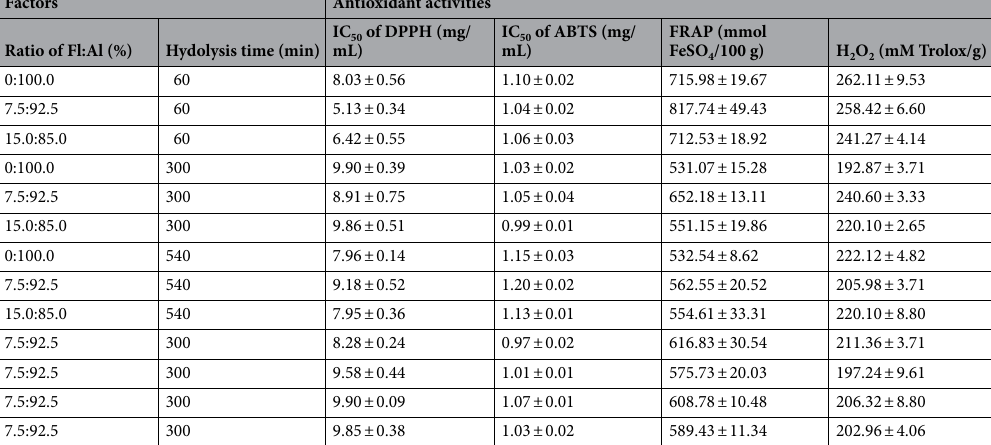
Table 2. Antioxidant activity of rice bran protein hydrolysates with various independent factors. Note: All values are Mean ± SD of three individual determinations.